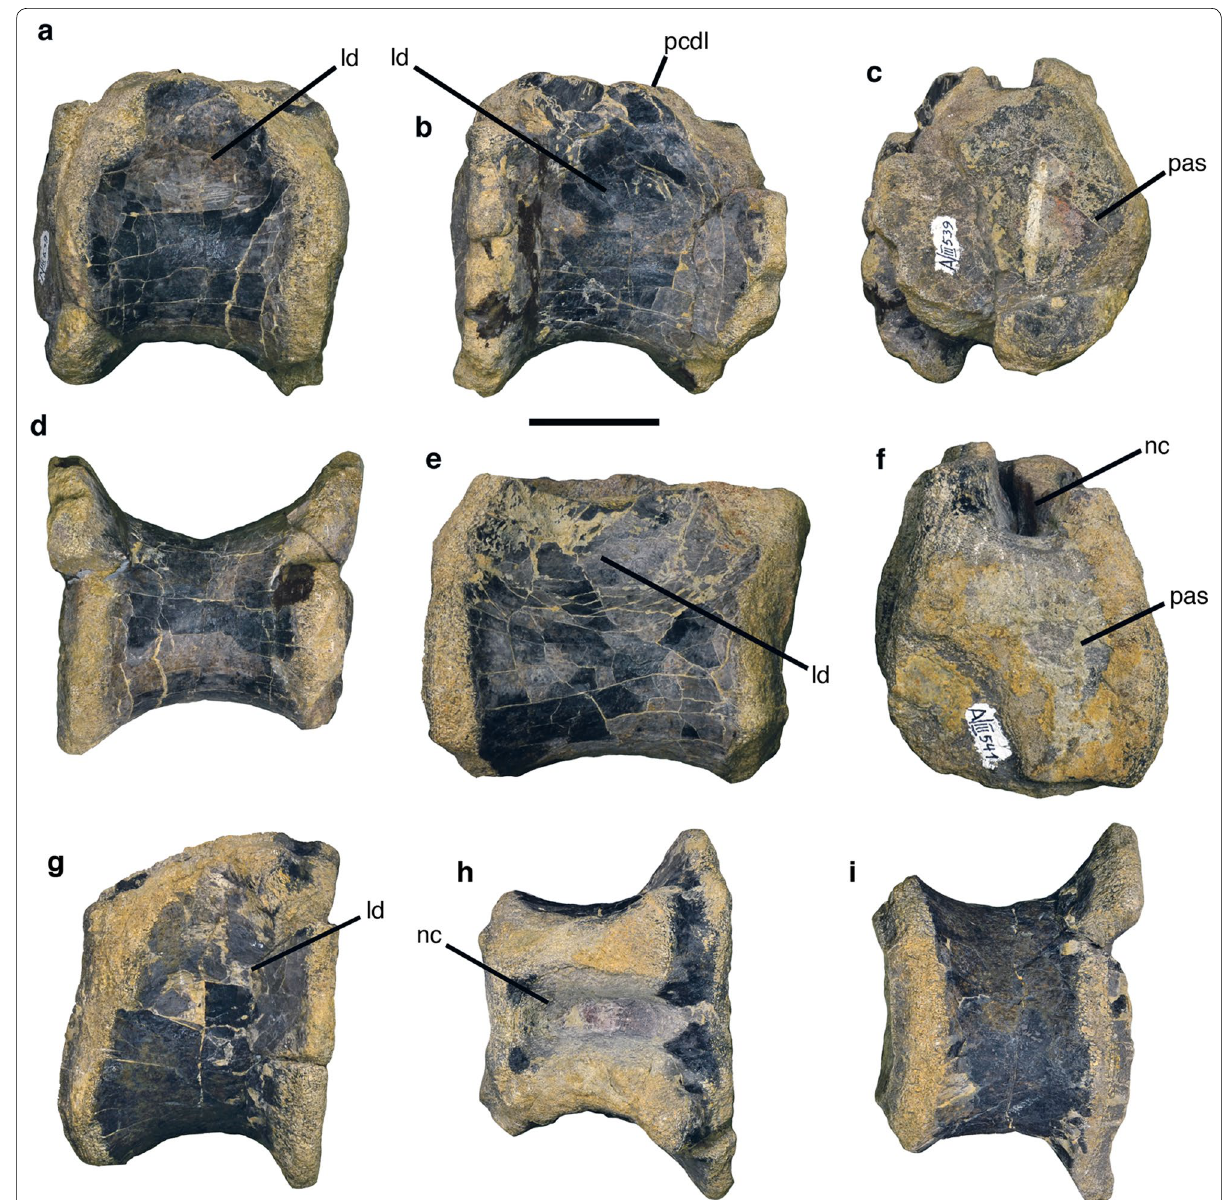
Fig. 5 Mid and posterior dorsal vertebrae of Schleitheimia schutzi n. gen., n. sp. a – d Mid dorsal vertebral centrum, PIMUZ A/III 539, in right ( a ) and left ( b ) lateral, anterior ( c ), and ventral ( d ) views; e, f mid dorsal vertebral centrum, PIMUZ A/III 541, in lateral ( e ) and posterior ( f ) views; g – i posterior dorsal vertebral centrum, PIMUZ A/III 545, in lateral ( g ), dorsal ( h ) and ventral ( i ) views. ld, lateral depression; nc, neural canal; pas, posterior articular surface; pcdl, posterior centrdiapophyseal lamina. Scale bar is 5